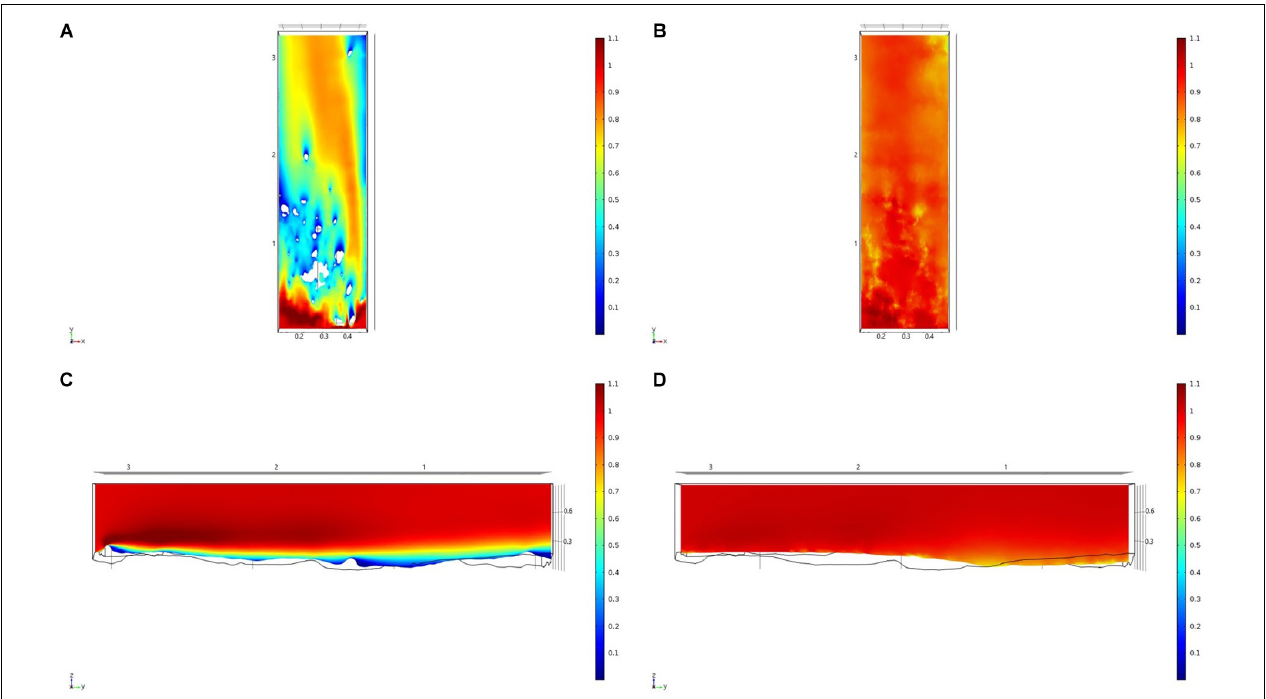
FIGURE 9 | Results of the fluid flow finite element analysis simulation for surface models for HOK Study area visualized as two-dimensional plots (horizontal and vertical cross sections) of flow velocity magnitude (false-color scales m/s). (A,C) Surface model with sponges present. (B,D) Surface model with sponge structures removed. Scale in m with ambient flow of 1 m/s along the y